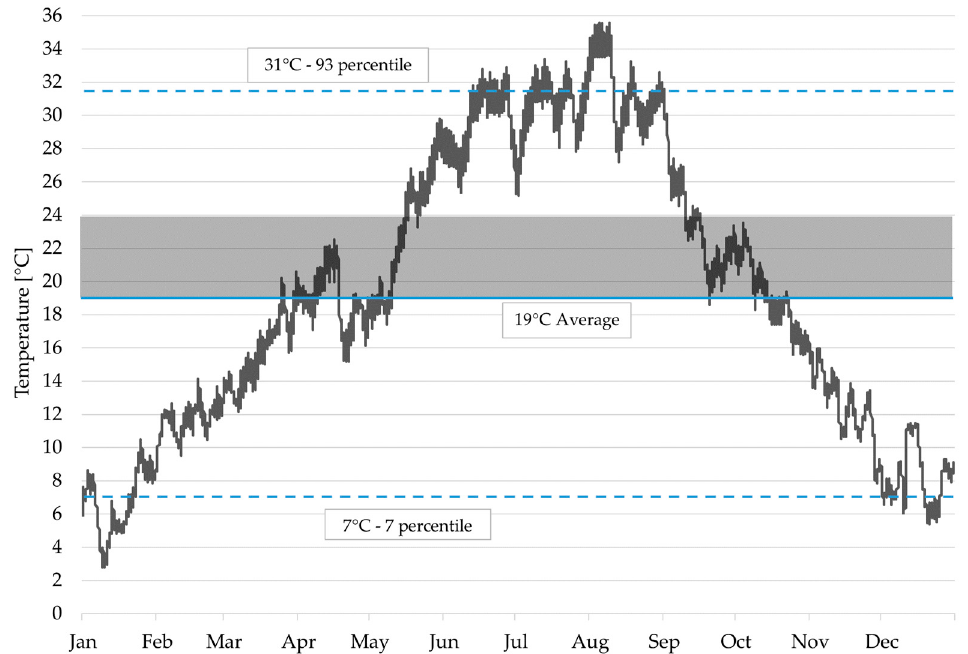
Figure 14. Trend of historic climate hourly values of T and statistical limits of 93rd and seventh percentiles in position B vs. the range recommended by the Italian D.M. 10.05.2001 [16] (gray band).